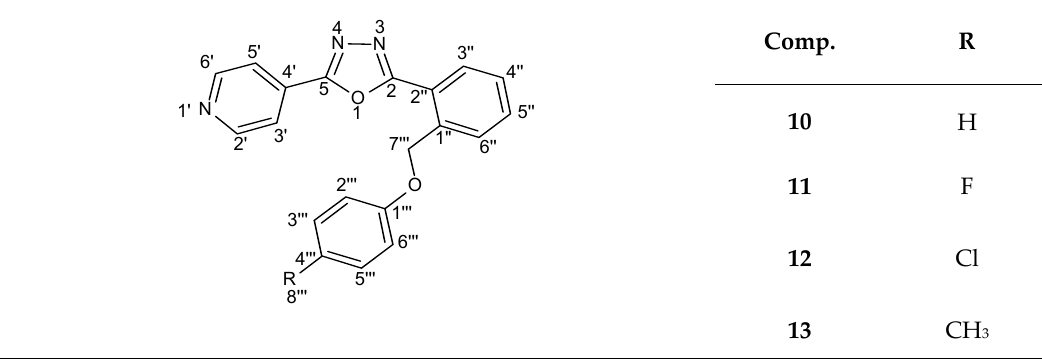
Figure 9. General formula of newly synthesized 1,3,4-oxadiazoles (compounds 10 – 13 ).